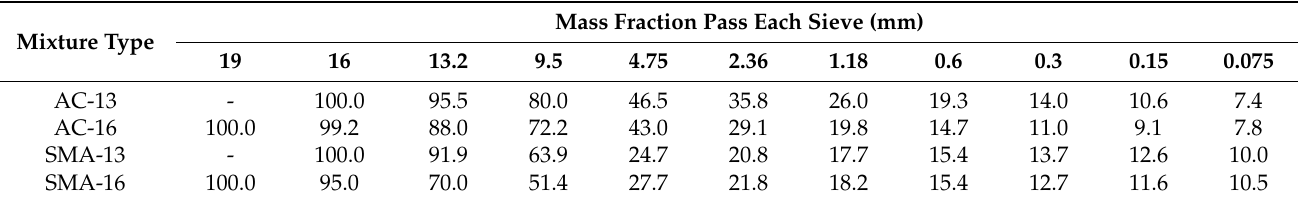
Table 4. Aggregate gradations of asphalt mixture (unit: %).